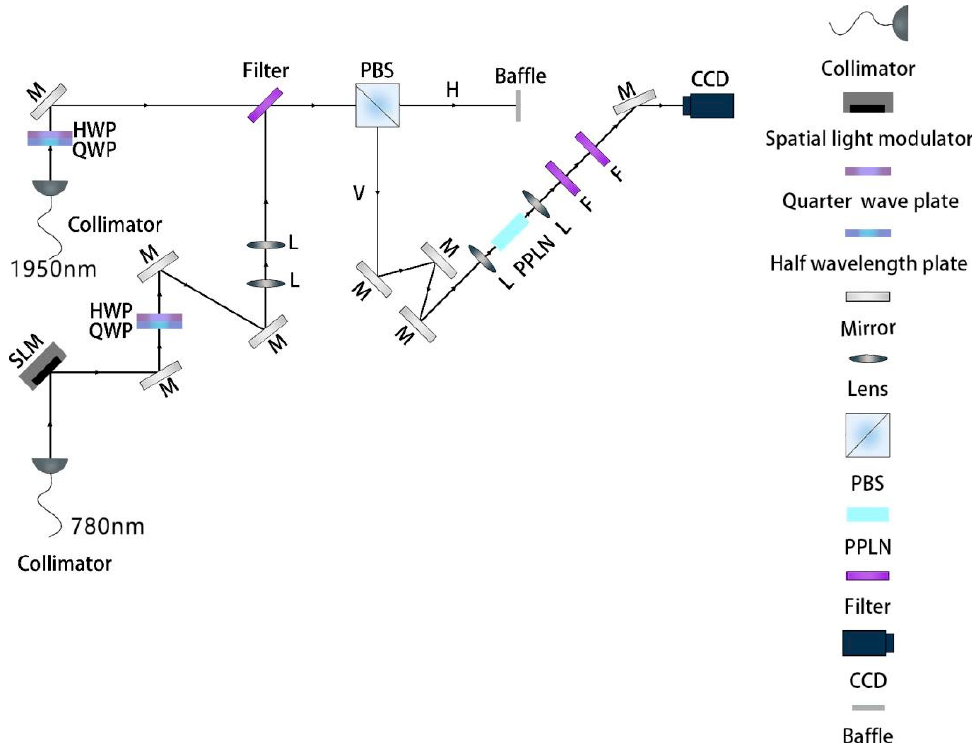
Figure 1. Schematic diagram of the experiment. ( a ) Photon Energy Conservation. ( b ) Photon Mo- mentum Conservation. ( c ) Periodically reverse domain with Period ⋀ , which creates wave vector G QPM == 2 / ⋀ for the quasi-phase-matching (QPM) interaction.